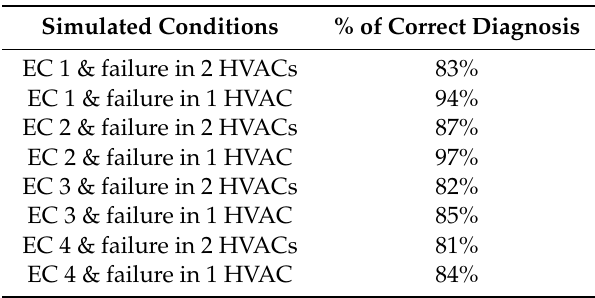
Table 10. Results of the